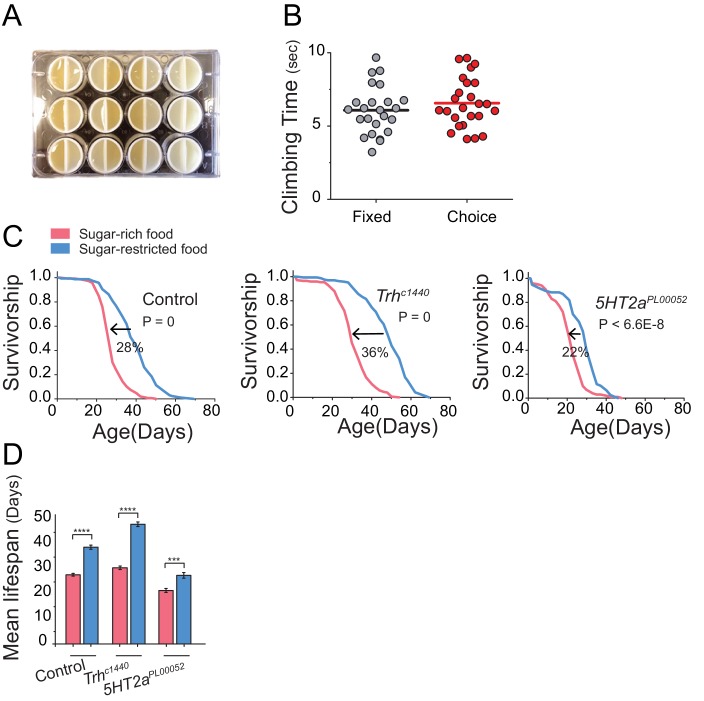
Health and Lifespan of Trh and 5HT2a mutants in various diet conditions.(A) We printed plastic vial dividers using a Form 1+ 3-D printer to retrofit standard 12-well cell culture plates. These were then placed underneath acrylic chambers to create conditions in which aging flies were able to choose from two different feeding wells throughout their lifespan. These wells were then filled with identical (control) or nutrient-specific diets. (B) Analysis of total time taken to reach the top of the chamber in the negative geotaxis assay of Canton S. female flies kept on fixed or choice diets (Mann-Whitney U-test, P>0.05). (C) The high sucrose diet significantly reduces lifespan of control (w1118) flies and flies with mutation in Trh and 5HT2a (log-rank test). (D) Mean lifespan of flies exposed to either sugar-rich or -restricted diets. For mean lifespan, statistical significance was determined by one-way ANOVA followed by Tukey’s multiple-comparison (***P≤0.001, ****P≤0.0001). Based on cox-regression analysis, we found significant interaction between genotype and diet effect for Trh mutant (P=1.1E-1) and 5HT2a mutant (P=3.1E-2).